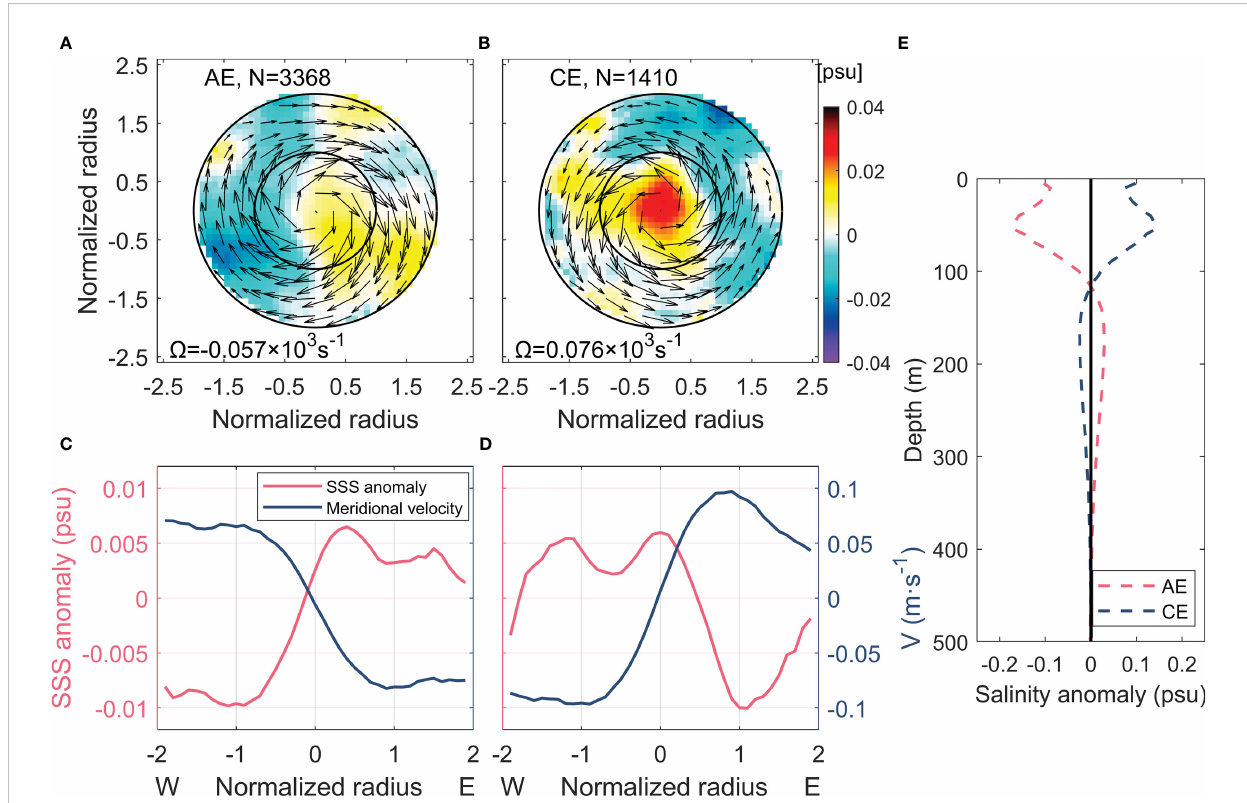
FIGURE 3 Normalized eddy salinity anomaly (shading, unit: psu) and current anomaly (vector, unit: m·s -1 ) composites of (A) AE and (B) CE in the SCS. The number of eddy samples and eddy vorticity ( W ) are marked on each subgraph. The mean SSS anomaly (red line) and meridional velocity (blue line) of the AE and CE along the zonal section are shown in (C, D) , respectively. (E) Mean salinity anomaly pro fi les of AE (dotted red line) and CE (blue line) in the SCS based on the SCSPOD